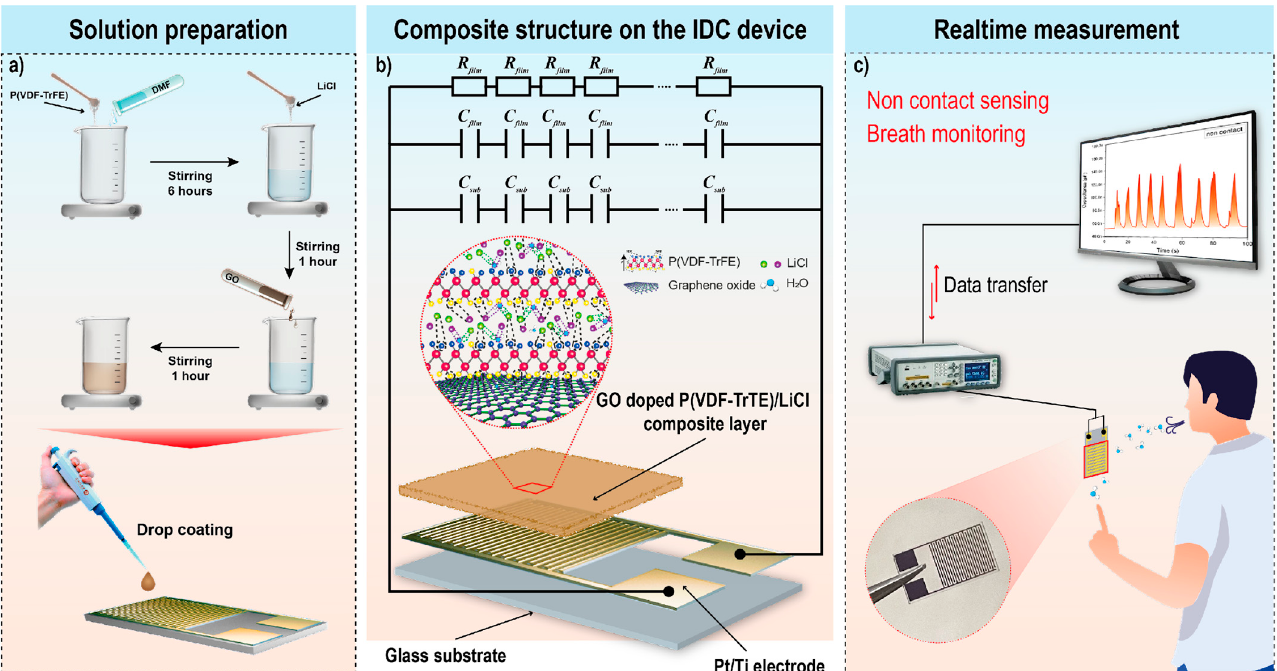
Figure 1. Schematic of the fabrication and measurement processes of a GO-doped P(VDF-TrFE)/LiCl-composite-based humidity sensor. ( a ) Process of solution preparation. ( b ) Equivalent circuit and the composite layer of the prepared GO-doped P(VDF-TrFE)/LiCl-composite-based sensor fabricated on an IDC electrode. ( c ) Real-time measurement of noncontact sensing and breath monitoring.